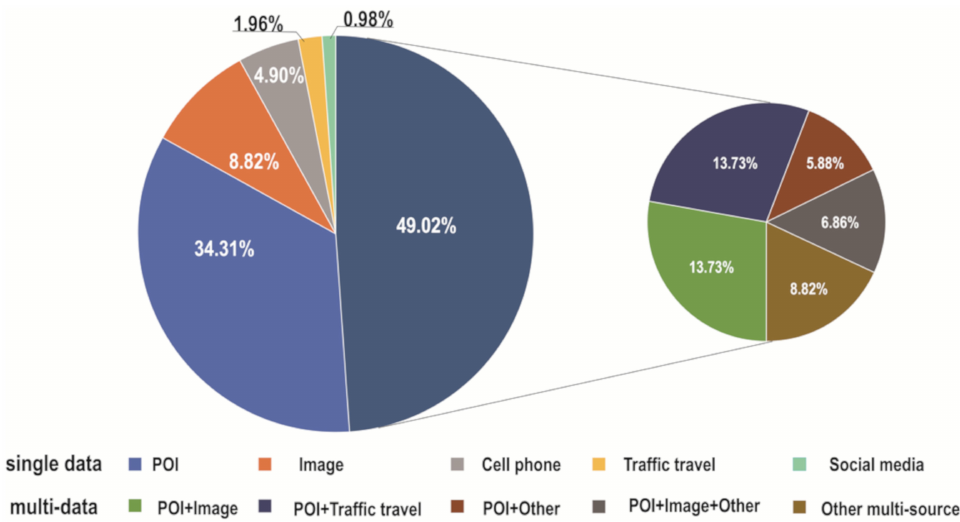
Figure 2. The statistics of the data sources of 102 papers.